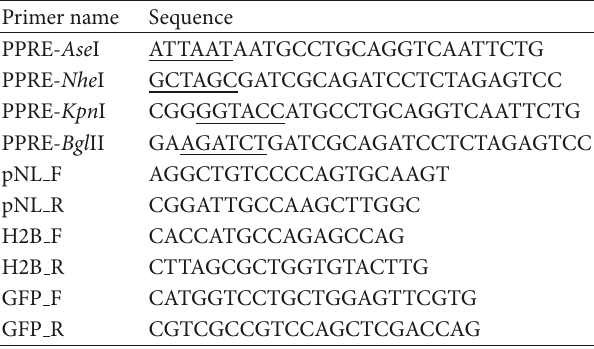
Table 1: Primers used to amplify DNA fragments by PCR for vector construction, confirmation, and generation of cloned